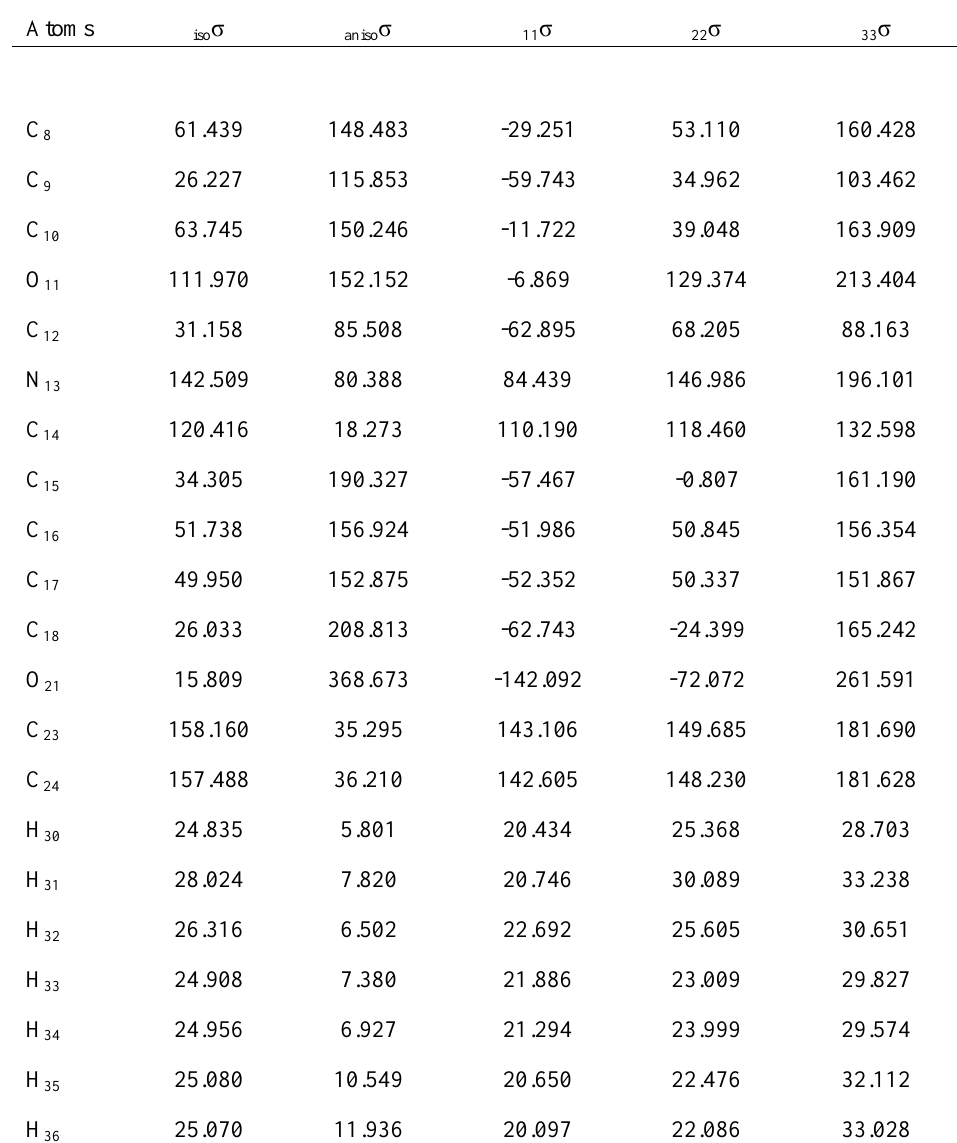
Table 7. The NMR Parameter Values (ppm) of 4i at B3LYP/6-311+G* Level (Atom Labeling Corresponds to Fig.